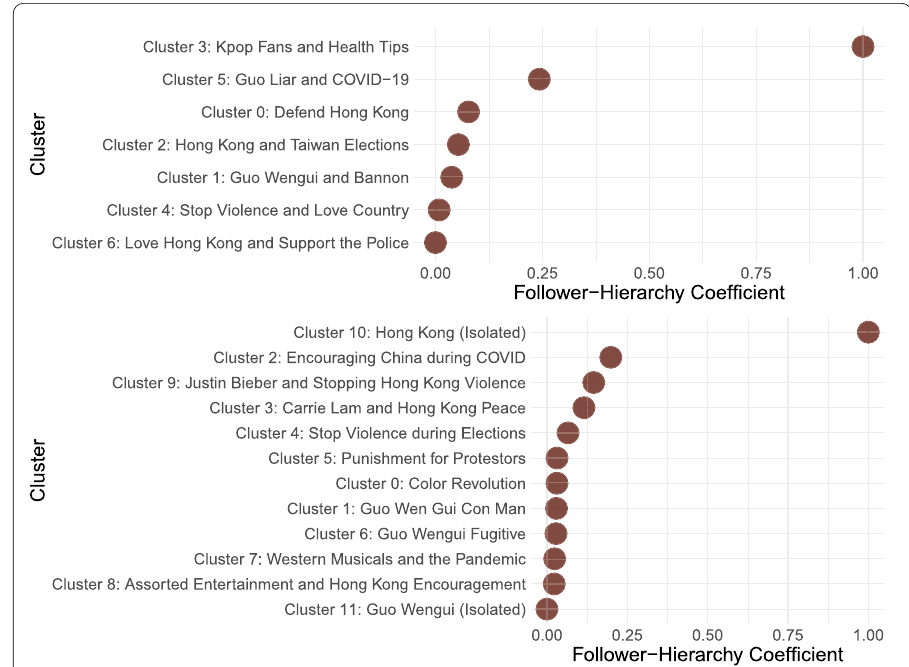
Figure 7 Follower-hierarchy coefficients for account clusters normalized to values between 0 and 1. Most clusters feature similar levels of hierarchical organization, with a few outliers exhibiting much stronger hierarchy. Top: Results for Era 1. Bottom: Results for Era